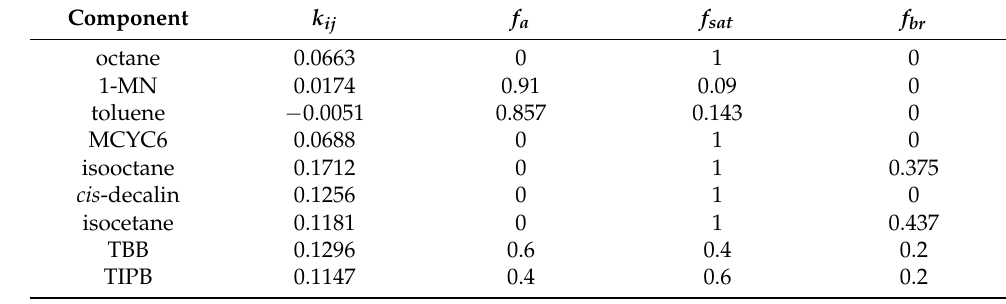
Table 3. Binary interaction parameters [12] between hydrocarbons and SBAD-1. Fraction of aromatic carbon ( f a ), fraction of saturated carbon ( f sat = 1 − f a ), and fraction of carbon which is alkane branches ( f br ). MCYC6 = methylcyclohexane, TBB = tert-butylbenzene, TIPB = 1,3,5-triisopropylbenzene, 1-MN =